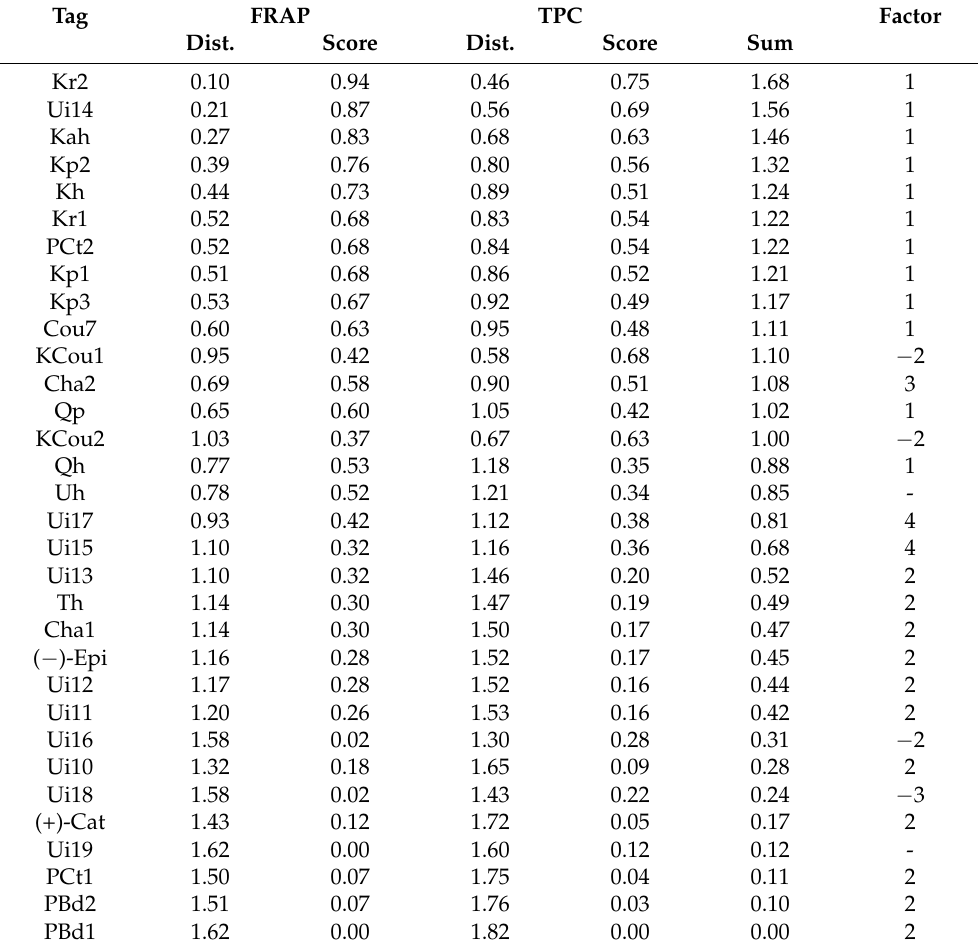
Table 6. Factor analysis of the polyphenol peak areas and the antioxidant properties of eastern hemlock cone extracts. “Factor” indicates the factor that correlates best with the given concentration of a given compound; “Dist.” is the Euclidian distance of a given compound from the FRAP or the TPC vector. FRAP: Ferric Reducing Antioxidant Power; TPC: Total Polyphenol Content. For the interpretation of the tags, please refer to Table